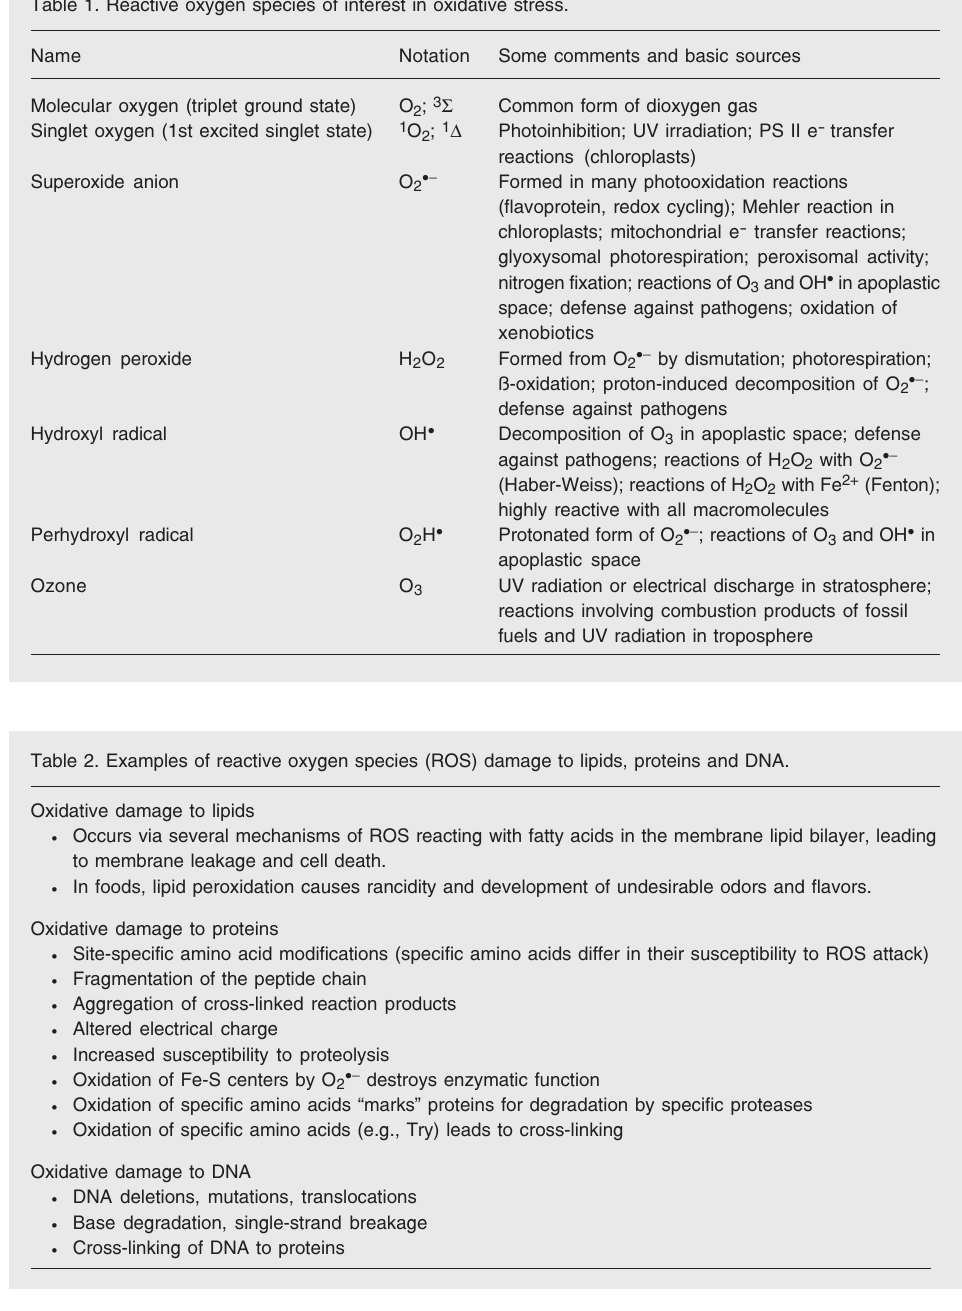
Table 1. Reactive oxygen species of interest in oxidative stress.